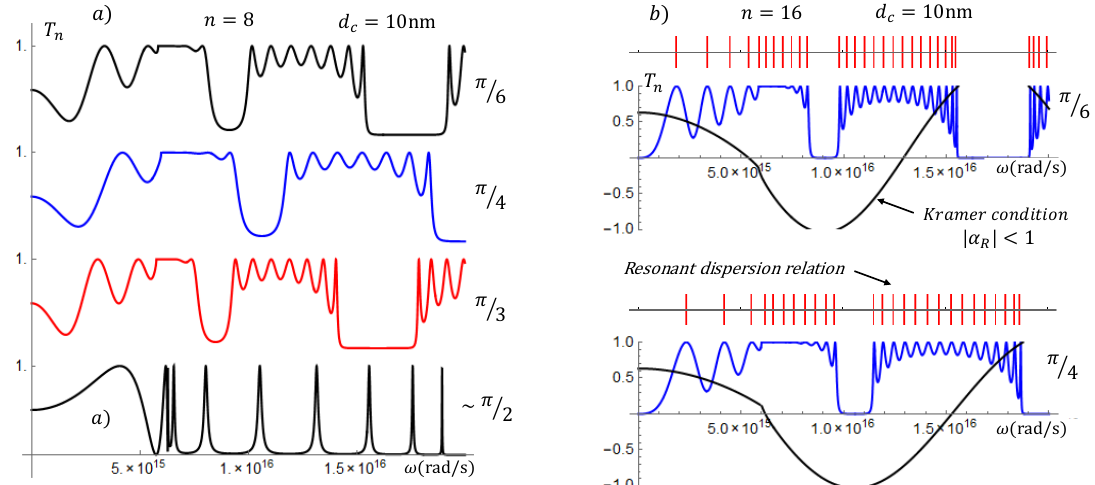
Figure 4. Transmittance as a function of the frequency through the metallic superlattices ( air / silver / air ) n . In ( a ) and ( b ), the thickness of the silver and air slabs is equal to d a = 100 nm and d c = 10 nm. In ( a ), the transmittance is shown for n = 8 and incidence angles θ i = π /6, π /4, π /3, and a slightly less than π /2. Below the plasma frequency ω p = 5.75 × 10 15 rad/s, the transmittance is an oscillating function of ω . Near the incidence angle of π /2, the transmittance is highly resonant. In ( b ), we repeat the transmittances for θ i = π /6, π /4, but now for n = 16, and we plot also the Kramer condition (black curves) and the dispersion relation of Equation (23) derived in the theory of finite periodic systems (red lines). It is clear that this recurrence relation predicts the bands and the frequencies of all the resonant